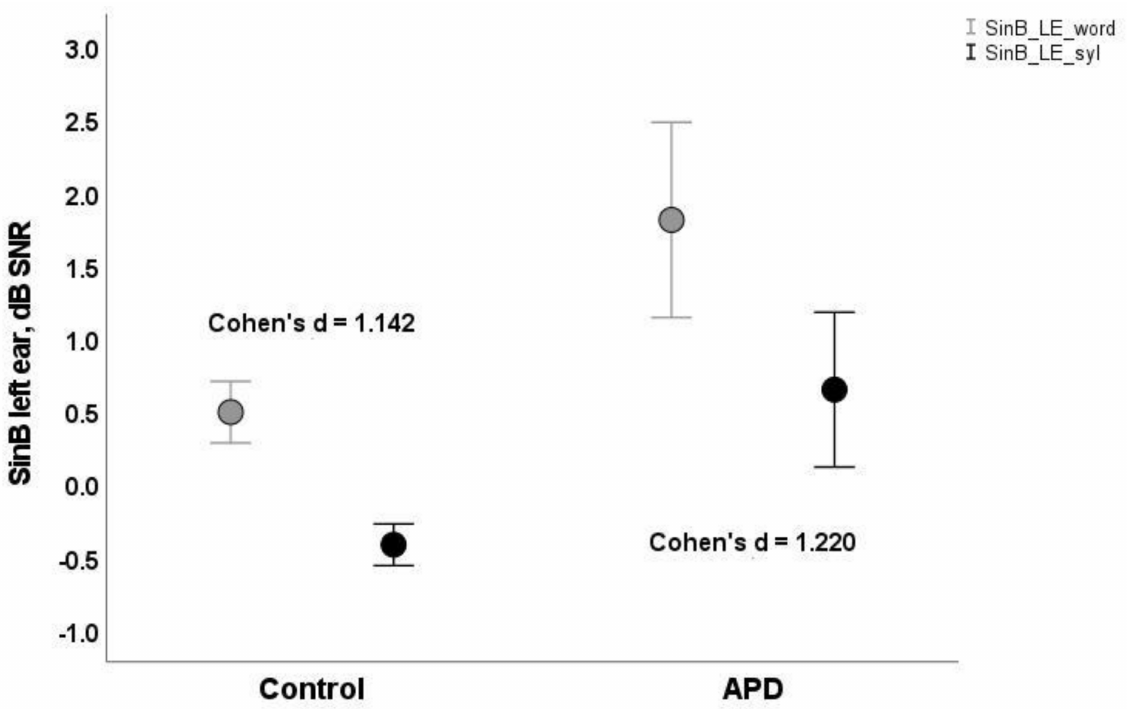
Figure 2. (SinB LE) Means and 95% error bars for SinB word (bright circles rectangles) and syllable- based scores (dark circles) for control and APD (Auditory Processing Disorder) children, left ear. Cohen’s d values refer to the effect size between typically developing and APD (Auditory Processing Disorder) groups for word and syllable-based